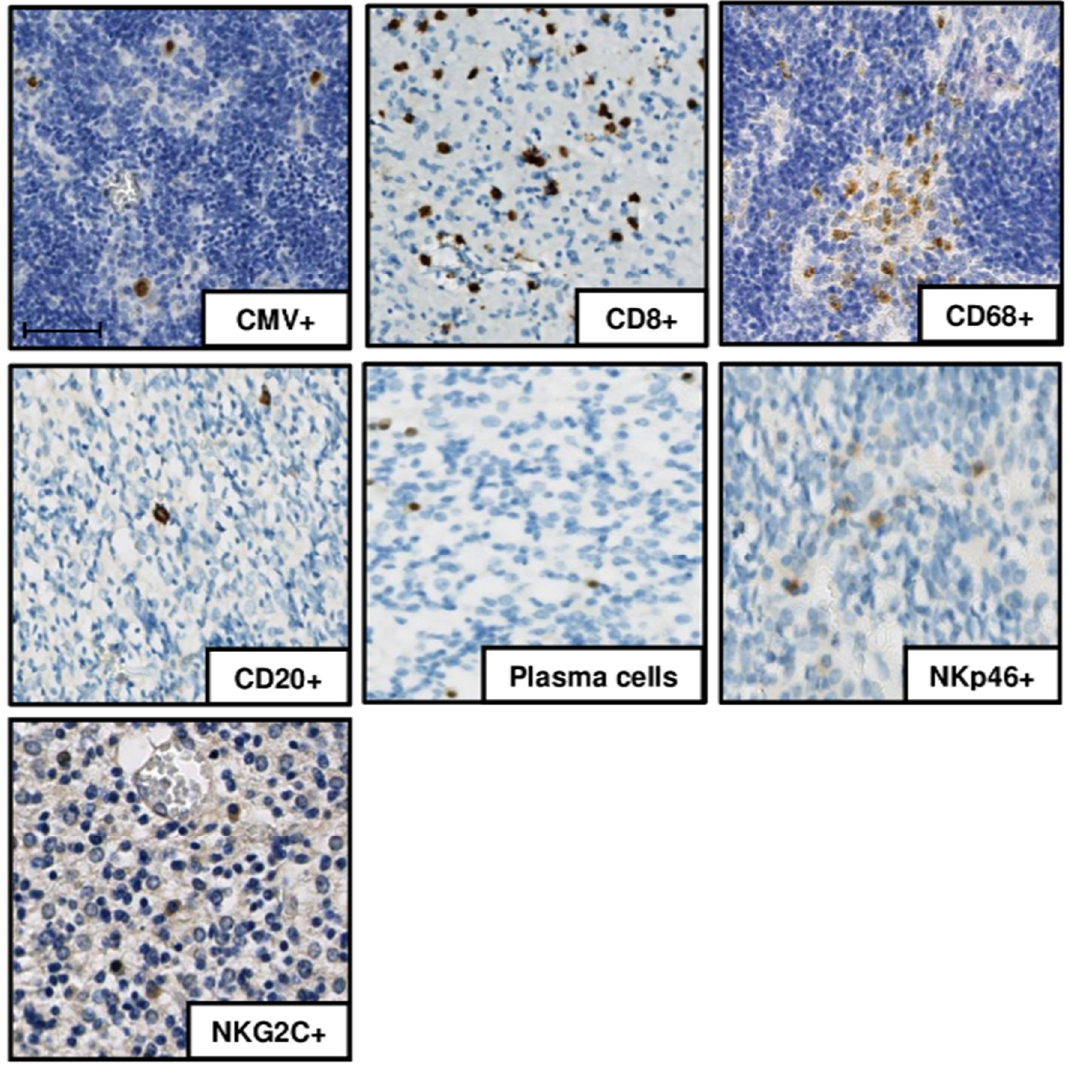
Figure 1. Immunohistochemistry results in one of the severely a ff ected brain samples (case 7). DAB-chromogen was used, and slides were scanned with a NanoZoomer 2.0 HT Digital slide